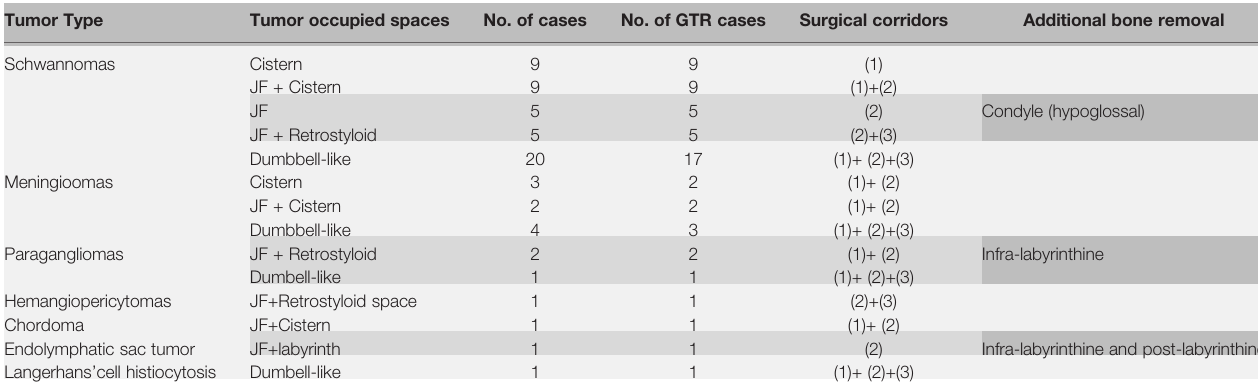
TABLE 1 | Tumor classi fi cations and surgical details.